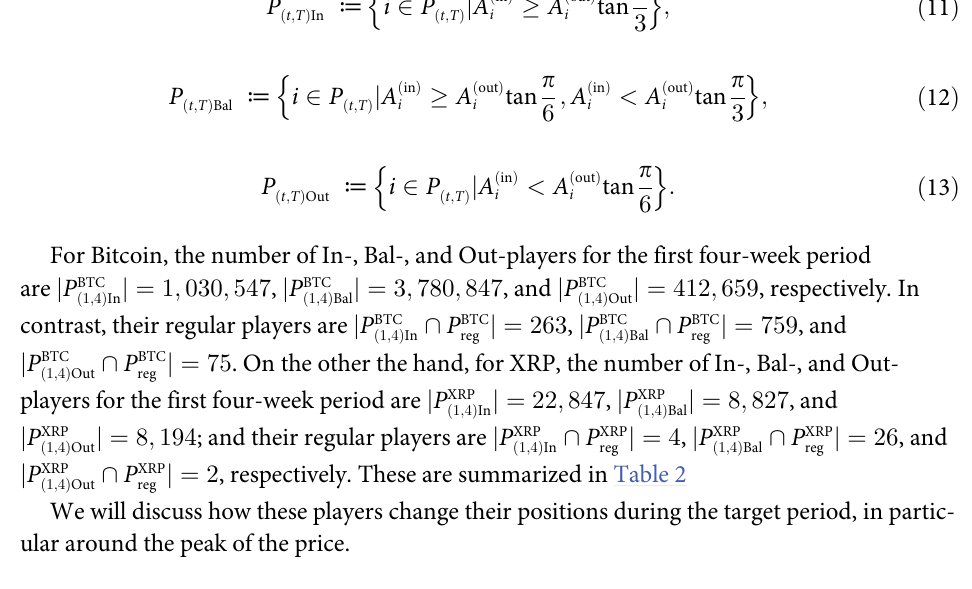
Table 2. The number of In-, Bal-, and Out-active and regular players for the first four-week period. Active players in the first 4-week